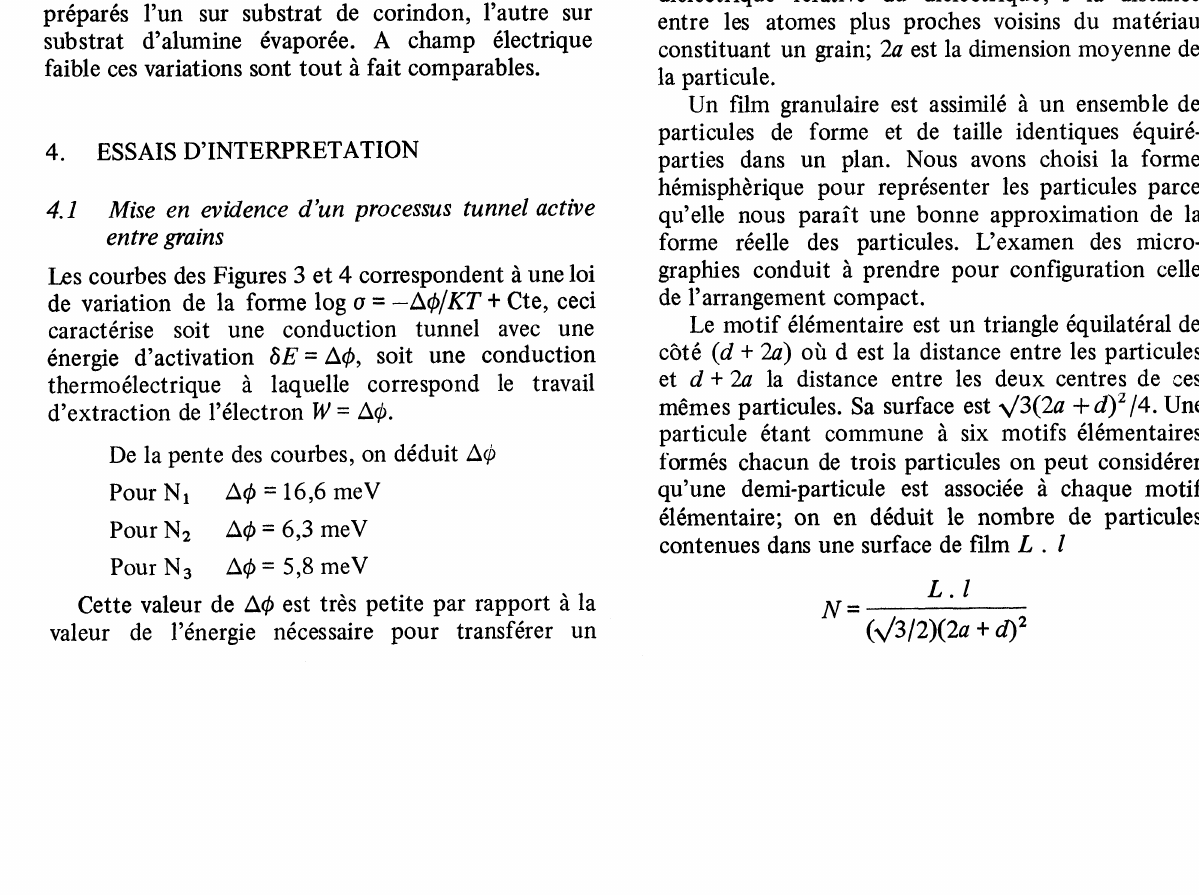
Variations de log o en fonction lIT pour deux 6chantillons de type N On constate que pour routes les couches, les variations de In o avec 1/T sont lin6aires. D’autre